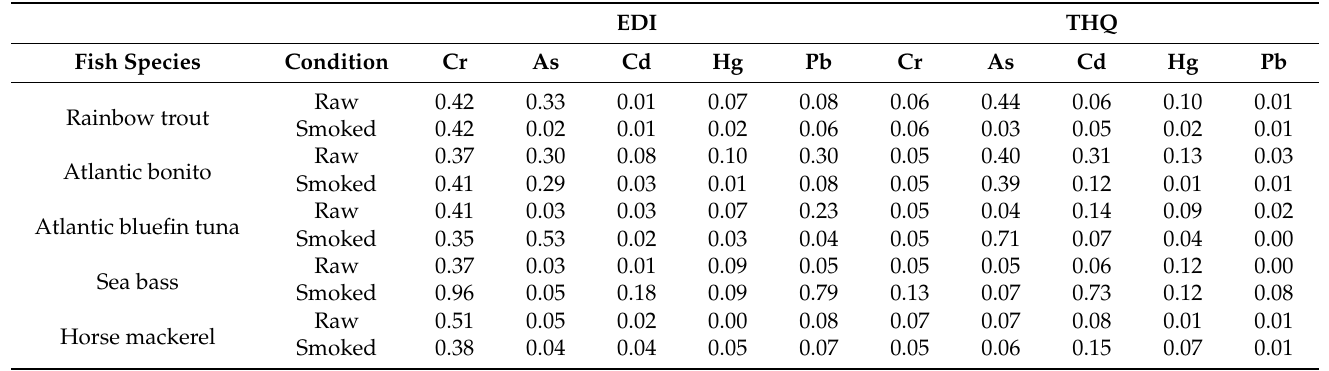
Table 6. Health Risk assessment of Heavy